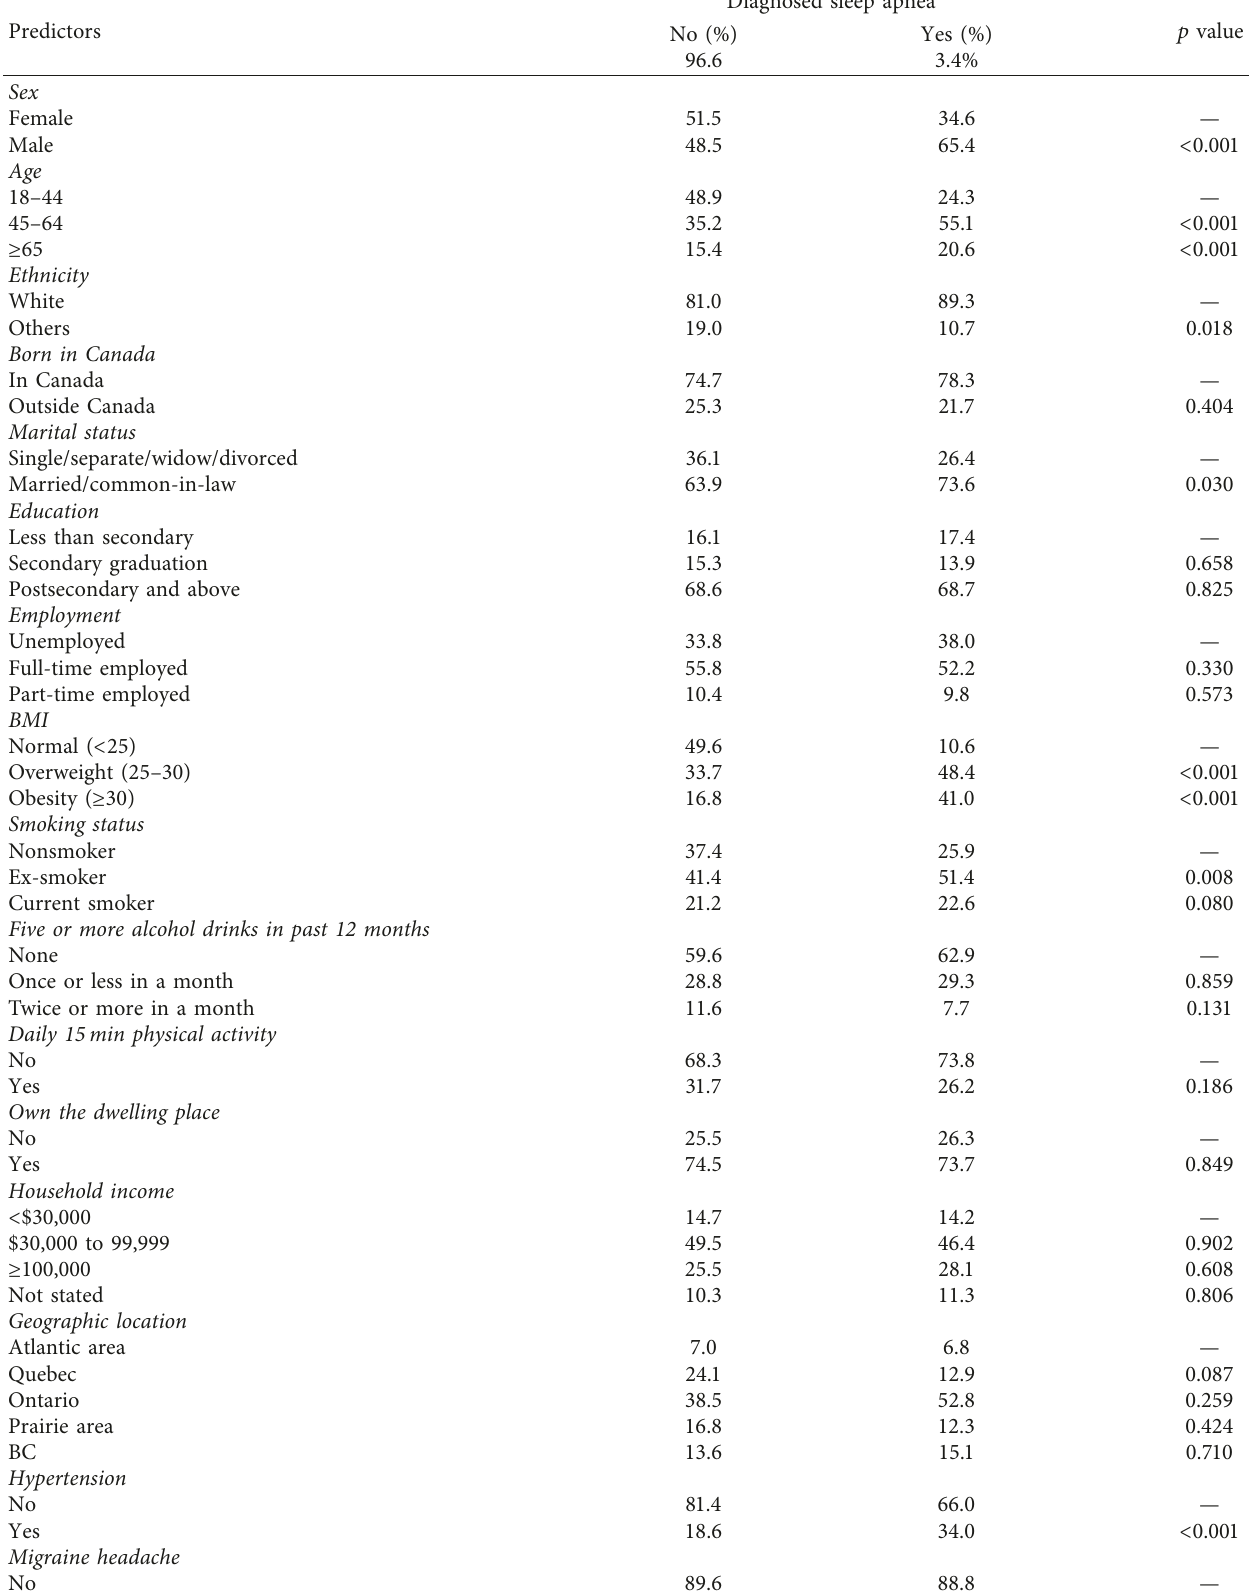
Table 1: Univariate associations between sleep apnea and independent variables of